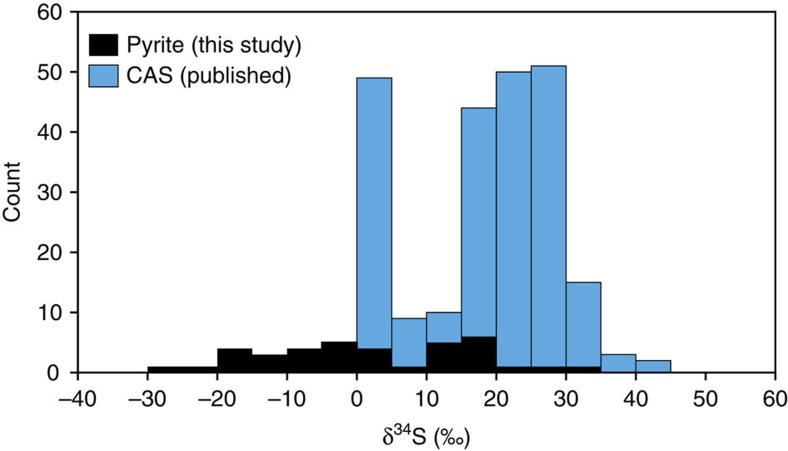
S-isotope systematics.Comparison of new δ34Spy data with published values of δ34Sseawater from Late Permian and Early Triassic CAS records4041. The overlap between the two δ34S records supports the inference of ferruginous conditions from Fe-speciation and suggests low background sulfate concentrations.